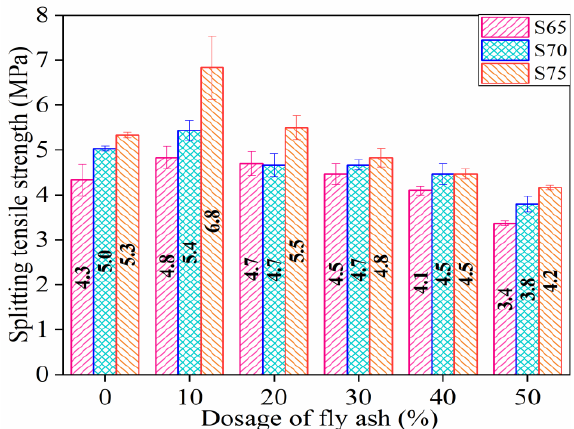
Figure 7. Splitting tensile strength of specimens.